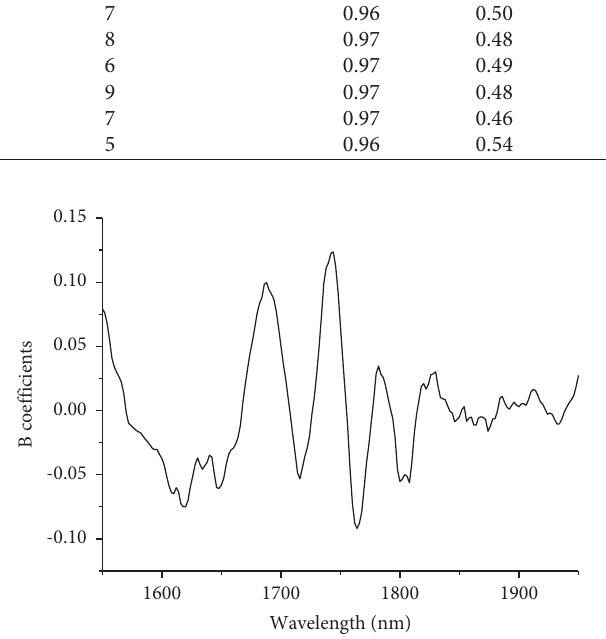
Table 3: Evaluation of the PLS calibration model for sample protein under different pretreatment methods. Pretreatment method